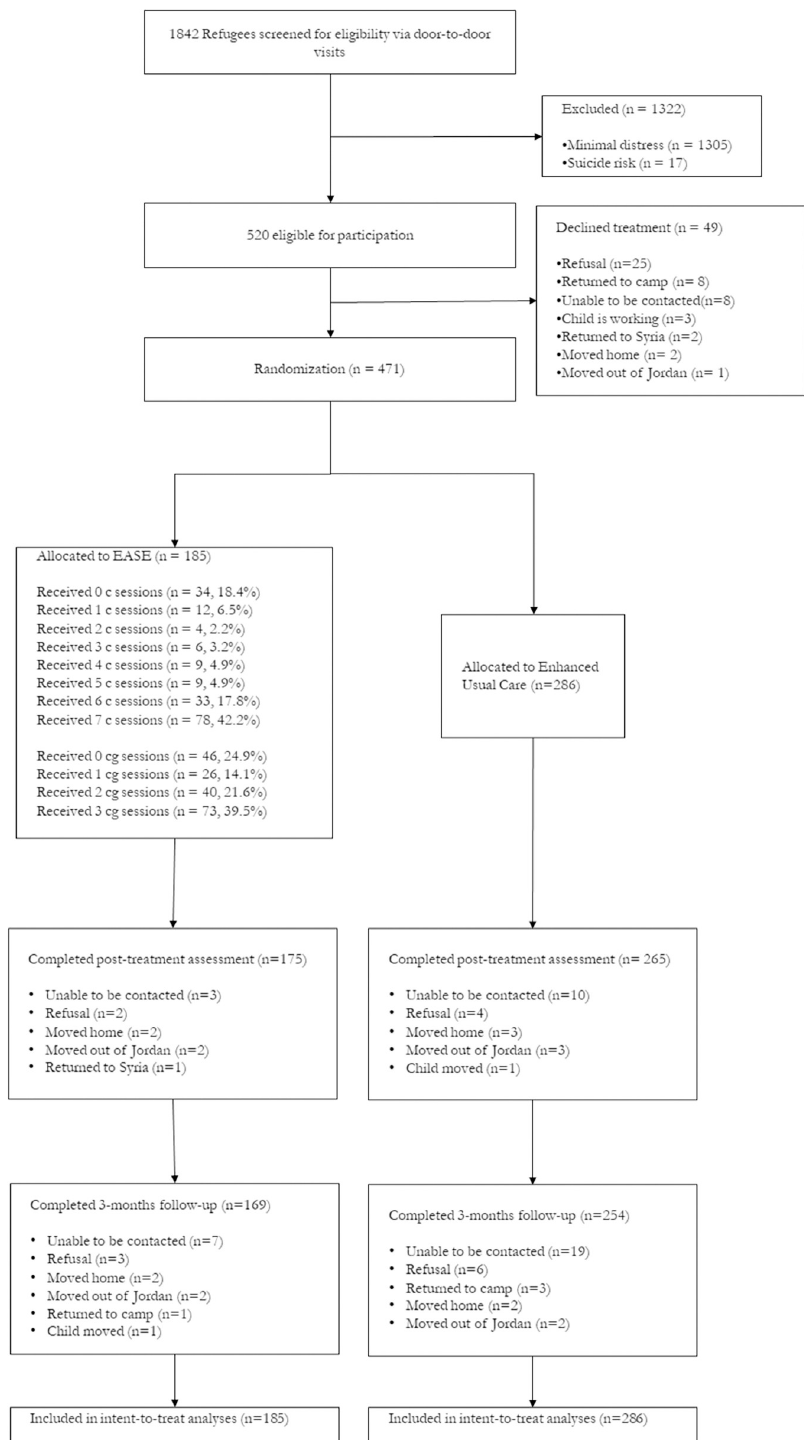
Fig 1. CONSORT flow diagram of progress through phases of a randomised trial comparing the EASE intervention vs. EUC in young adolescent Syrian refugees, Jordan. AU : AbbreviationlistshavebeencompiledforthoseusedinFig 1 andTables 1 and 2 : Pleaseverifythatallentriesarecorrect : EASE, Early Adolescent Skills for Emotions; EUC, enhanced usual